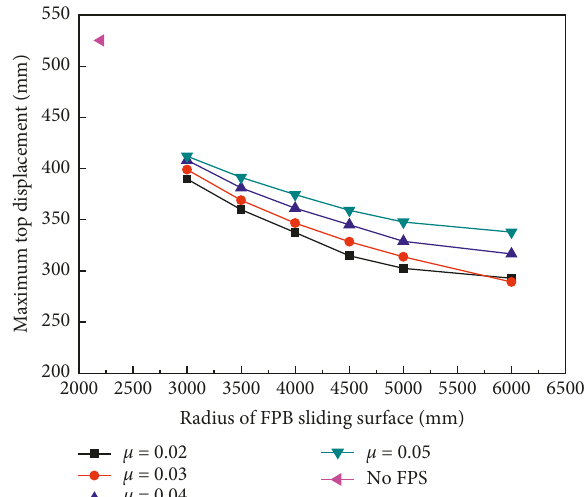
Figure 20: The maximum top displacement of T2 tower with R d and μ in the Y direction under L6501S wave.